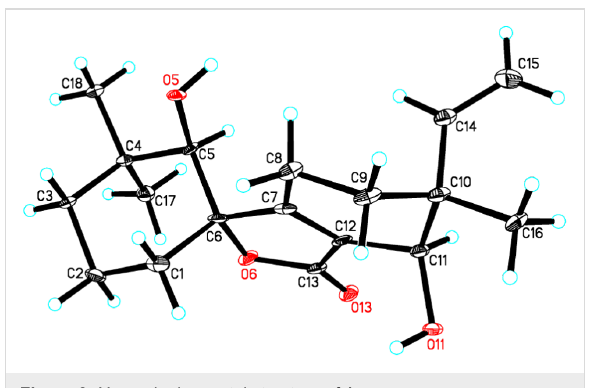
Figure 3: X-ray single-crystal structure of 1 .